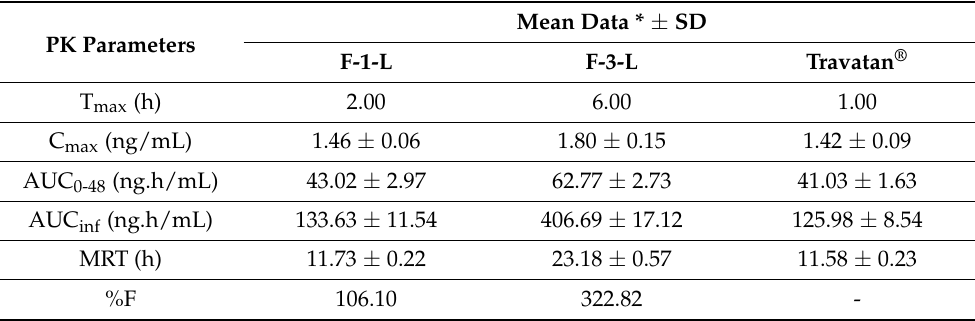
Table 7. The pharmacokinetic parameters of selected TRAVO-loaded LCNs formulae compared to Travatan ® measured in rabbits’ eye aqueous humor.